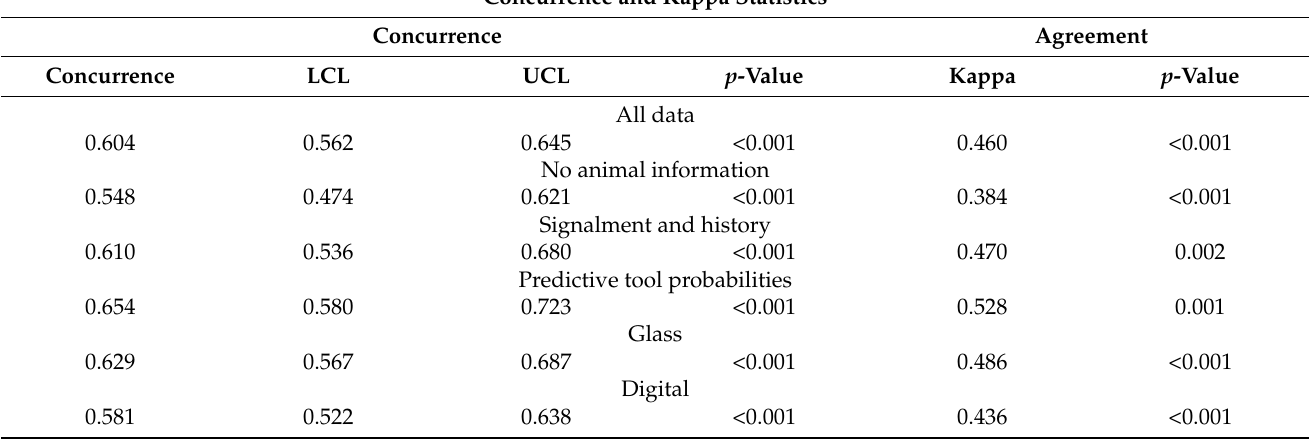
Table 7. Concurrence of the four pathologists’ diagnoses of canine and feline bladder tissues com- pared with the reference